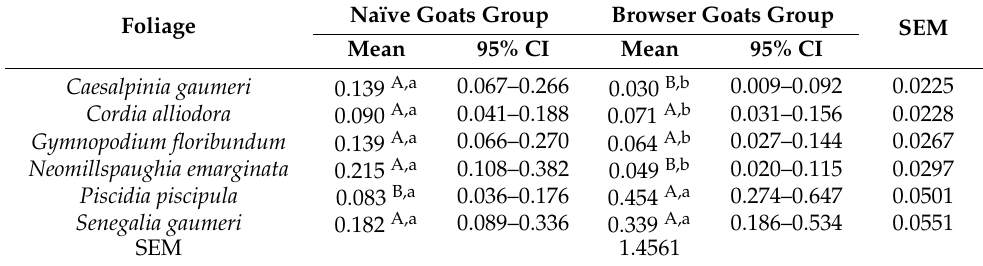
Table 2. Effect of browsing experience of juvenile goats on the selection index (95% confidence intervals; 95% CI) of six forage resources evaluated in a cafeteria trial lasting six days of observations (30 min/day).